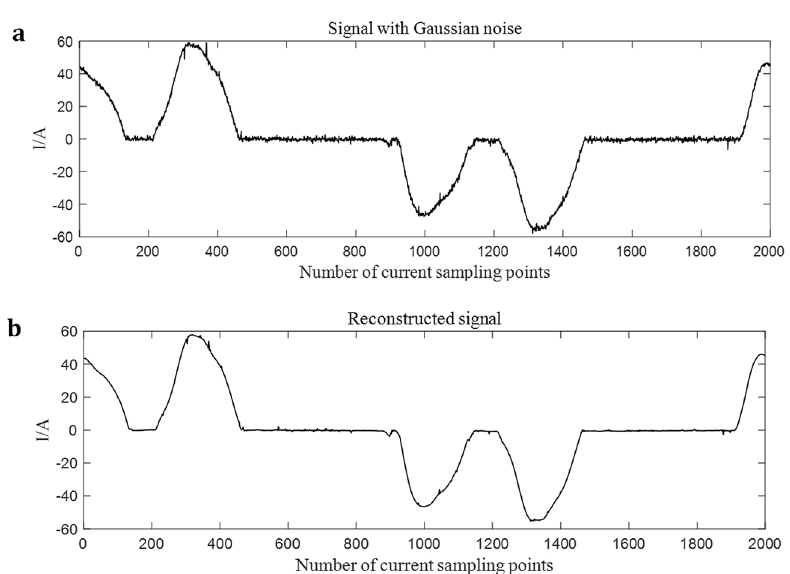
Figure 6. Signal with Gaussian noise and Reconstructed signal. ( a ) signal with Gaussian noise. ( b ) reconstructed